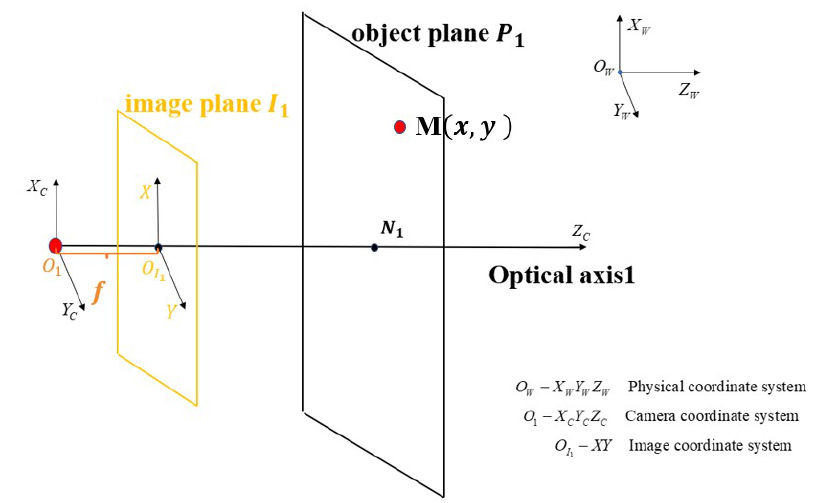
Figure 3. The relationship among three coordinates.